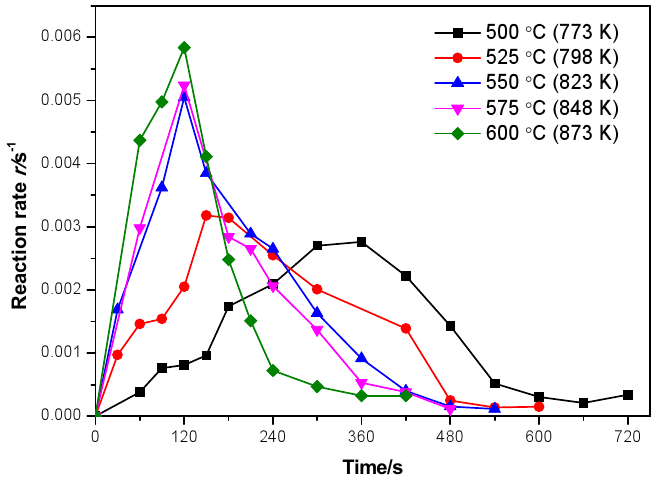
Figure 5. Reaction rate r vs. time for the selected process temperatures.